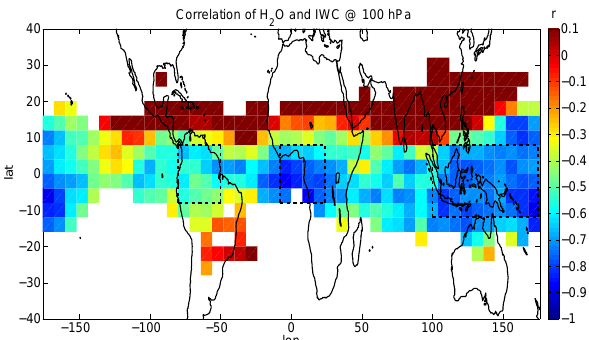
Fig. 4. Correlation map calculated with 19 seasonal data points of MLS water vapor and CALIPSO ice water content at 100hPa in each grid box. White areas indicate no IWC at 100hPa. The anti- correlation is close to -1 over Indonesia and still high over Africa and South America. A band of positive correlation (red) is found in the northern subtropics, Central America, India and East Asia. The reason is a different seasonal cycle of IWC, RHi and T due to a pronounced seasonal cycle of convection. The dashed boxes are the regions of interest discussed in the